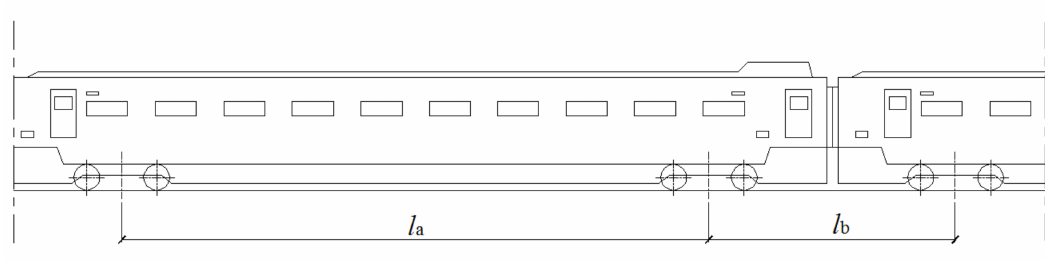
Figure 7. The geometric dimension of the